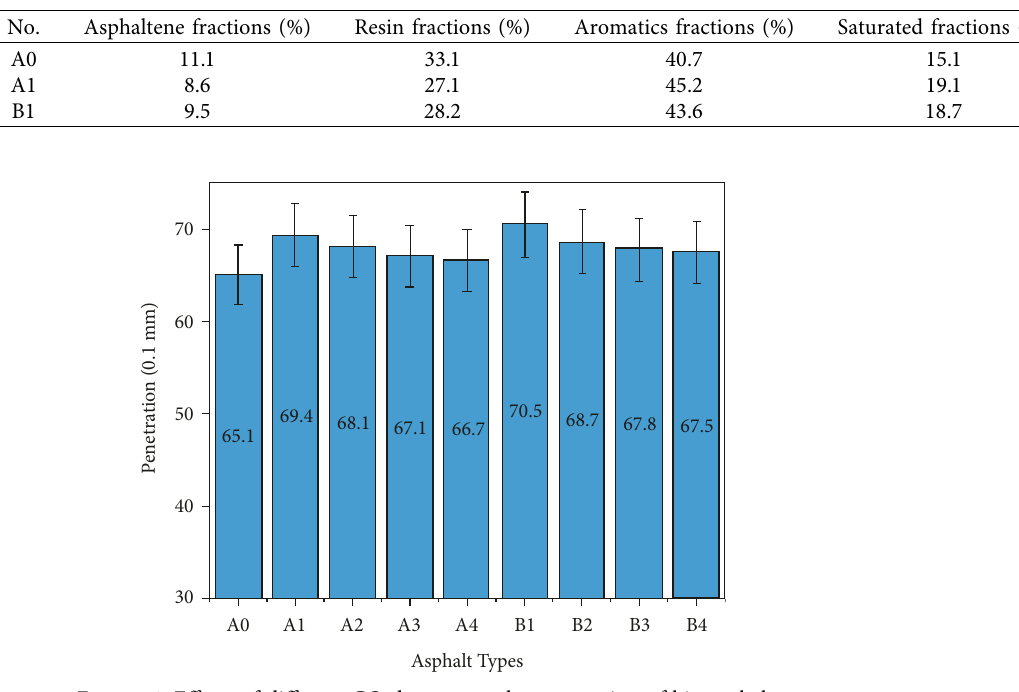
Table 5: Fractions of the two bio-asphalts.